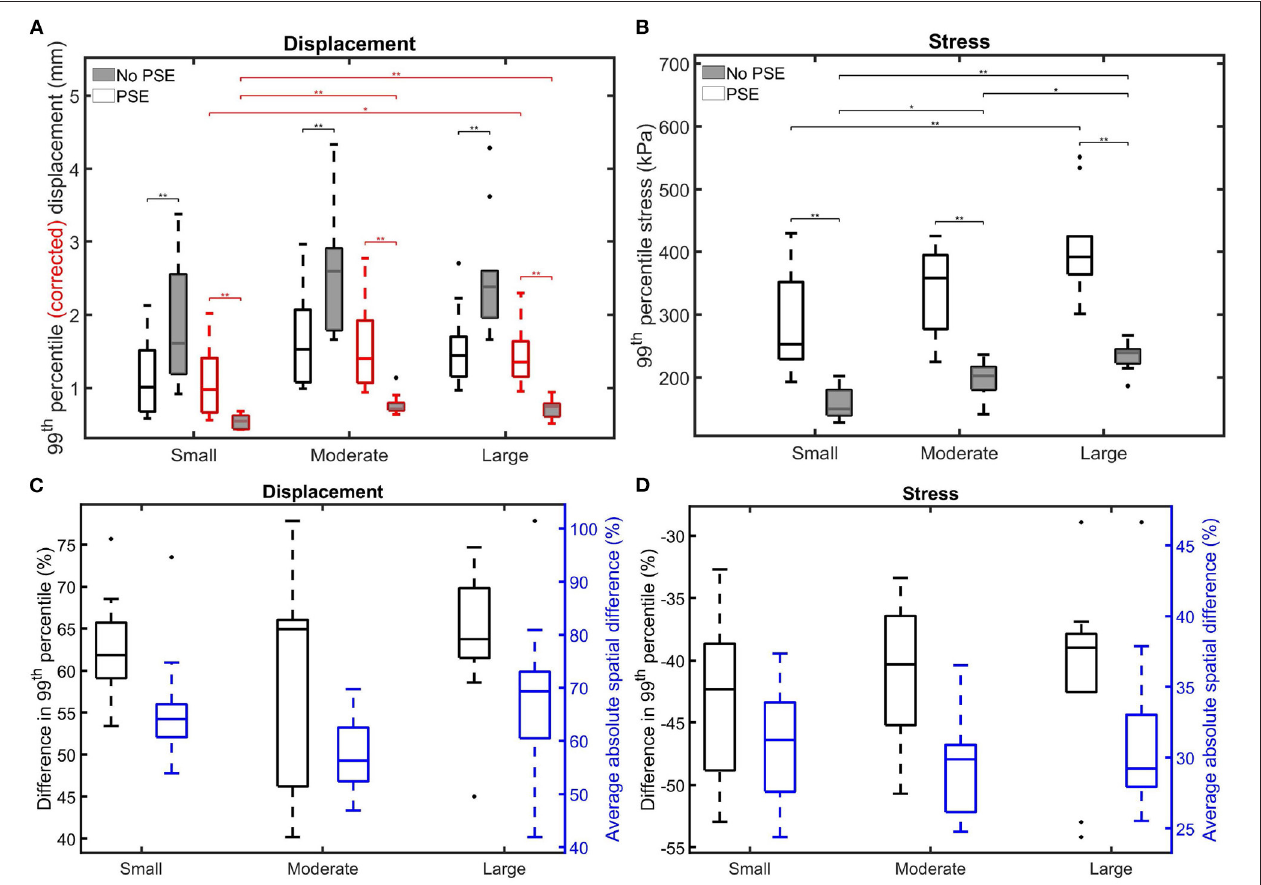
FIGURE 8 | Visualization of the 99th percentile systolic (A) (corrected) displacement and (B) wall stress for both FSI simulations for the different patient groups. The corrected displacement is shown in red. (C,D) Visualize the difference in 99th percentile (black) and average absolute spatial difference (blue) between the FSI simulations for the displacement and stress, respectively. Significant differences between groups are indicated with bars and stars ( ∗∗ p ≤ 1e-2, ∗ p ≤ 0.05).